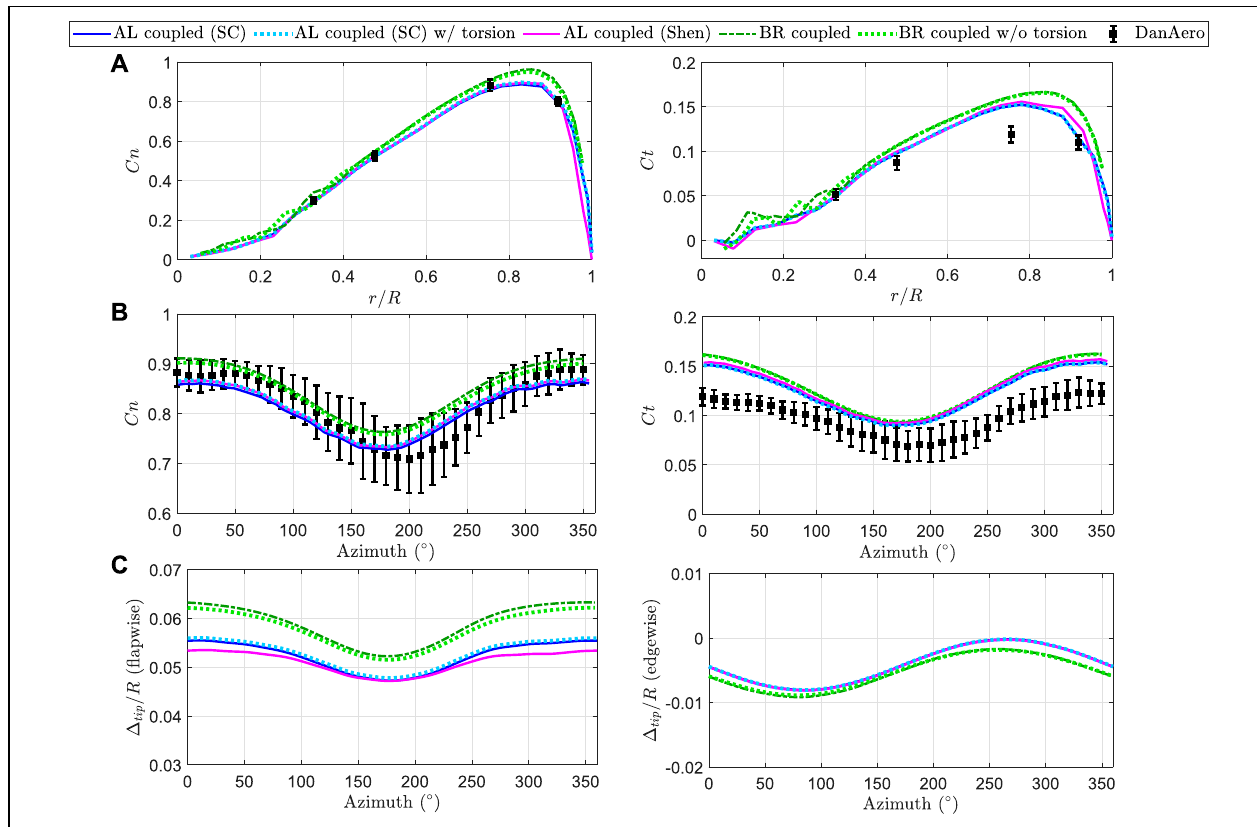
FIGURE 6 | Case 2: high shear and low yaw. (A) Normalised normal and tangential blade loads distribution at 0 ° azimuth; (B) Normalised normal and tangential blade loads at 75% radius; (C) Normalised flapwise and edgewise tip deflection.